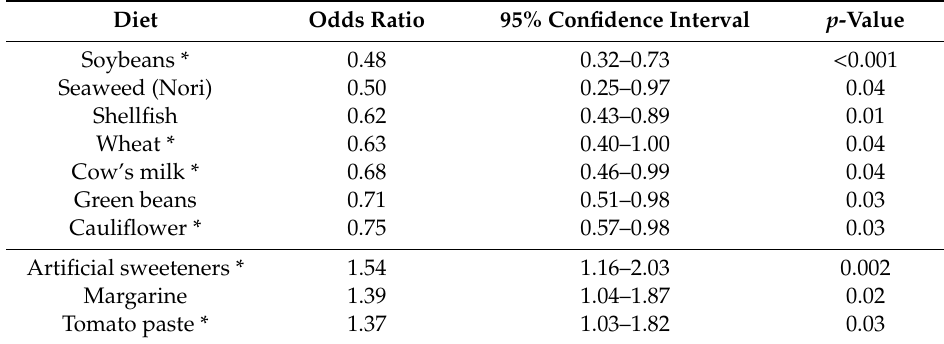
Table 2. Diets that reduce or aggravate abdominal pain and irregular stool